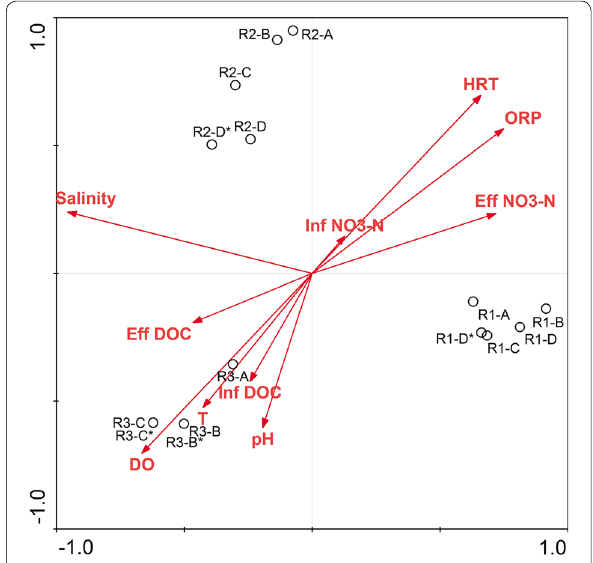
Fig. 3 Redundancy analysis (RDA) between sequencing result of genus level and environmental factors